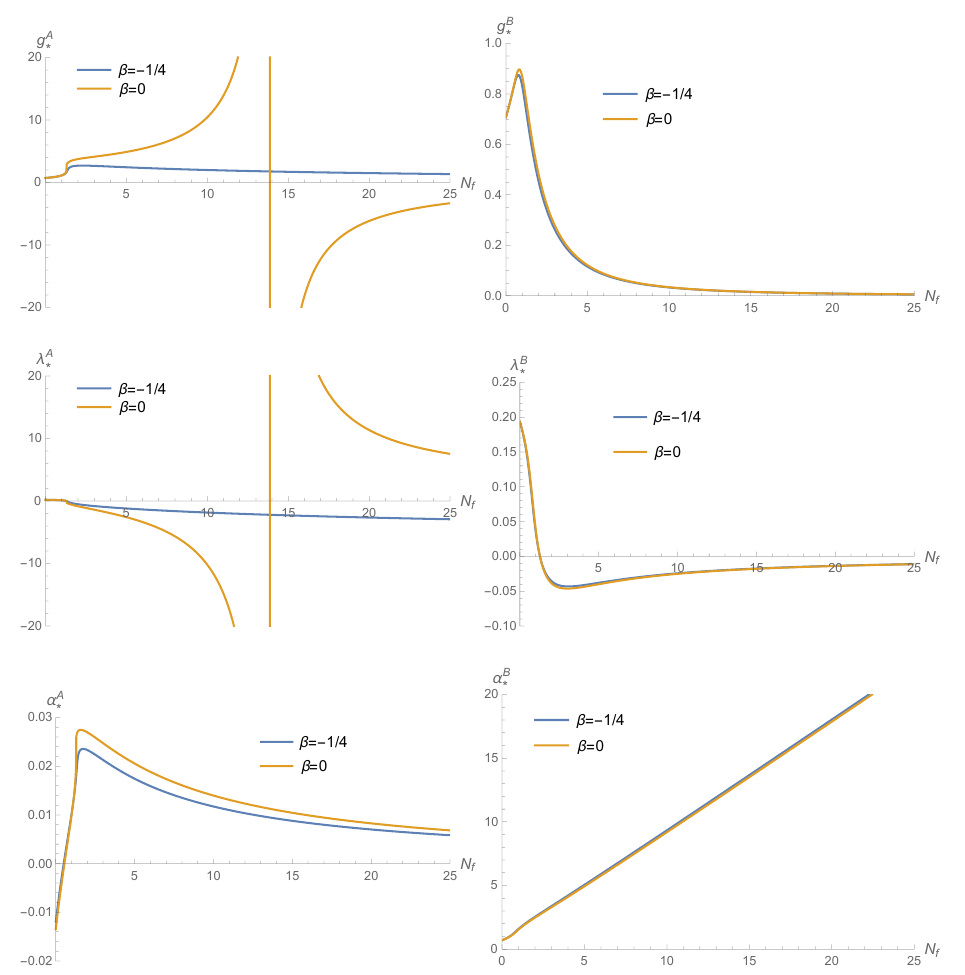
Figure 4. The position of the fixed points as a function of N f is shown for the system (50). The blue and yellow lines indicate the difference in β and, therefore, in the coarse-graining operator. Family A is characterized by α A ∗ ≈ 0 and structurally resembles the fixed points found at minimal coupling, cf. Figure 1. For β = 0 there is a critical number of fermions N crit that changes the sign of g A ∗ . Family f